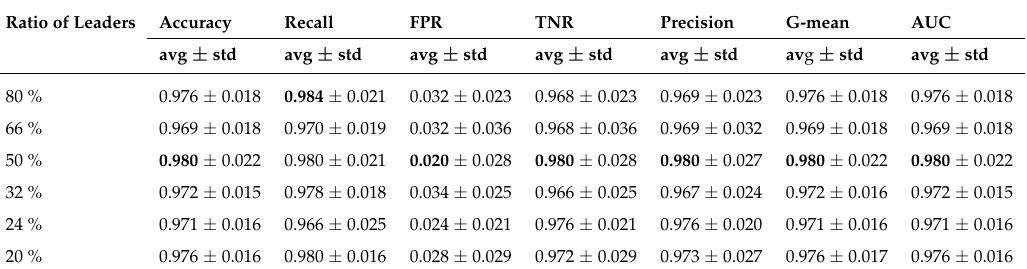
Table 3. The performance evaluation of the SSA algorithm at different ratios of leaders, in terms of average accuracy, recall, FPR, TNR, precision, g-mean, and AUC.